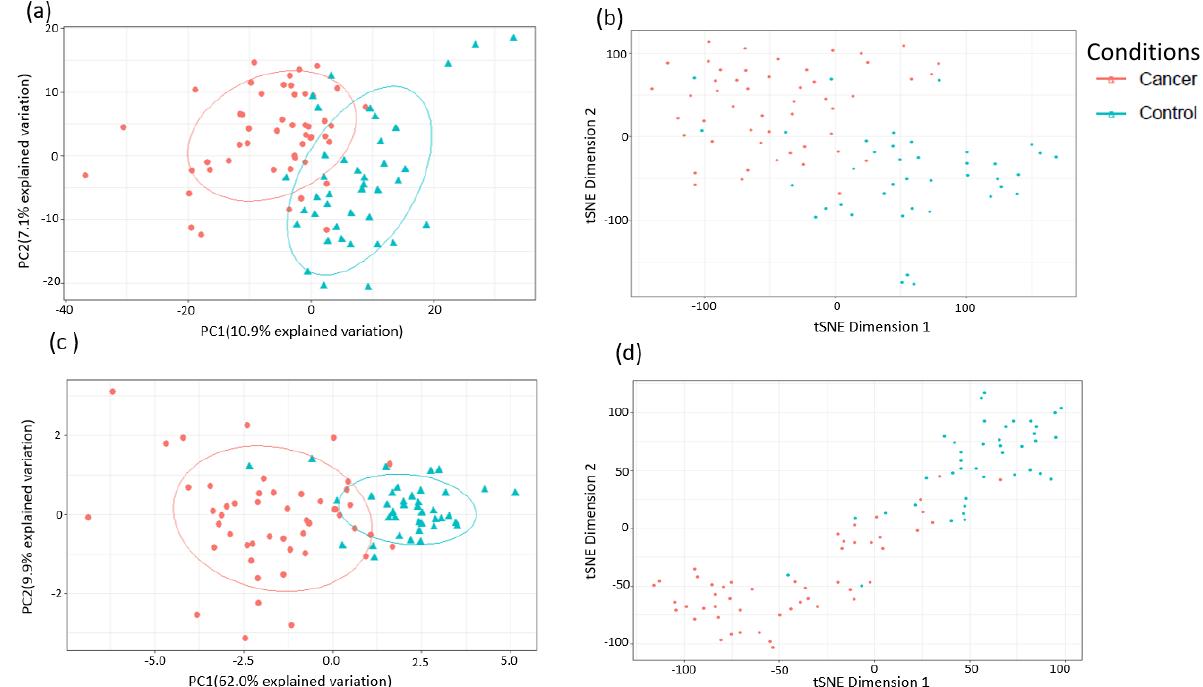
Figure 14. Analysis of sample separation after exclusion of women with type 2 diabetes mellitus (training set: n = 72, cancers = 40, controls = 32) based on PCA ( a , c ) and t-distributed stochastic neighbour embedding (t-SNE) ( b , d ) analyses using all identified metabolites ( a , b ) and the top 10 discriminatory metabolites ( c , d ) identified by random forest machine learning. t-SNE (perplexity: 5, iteration: 10000).